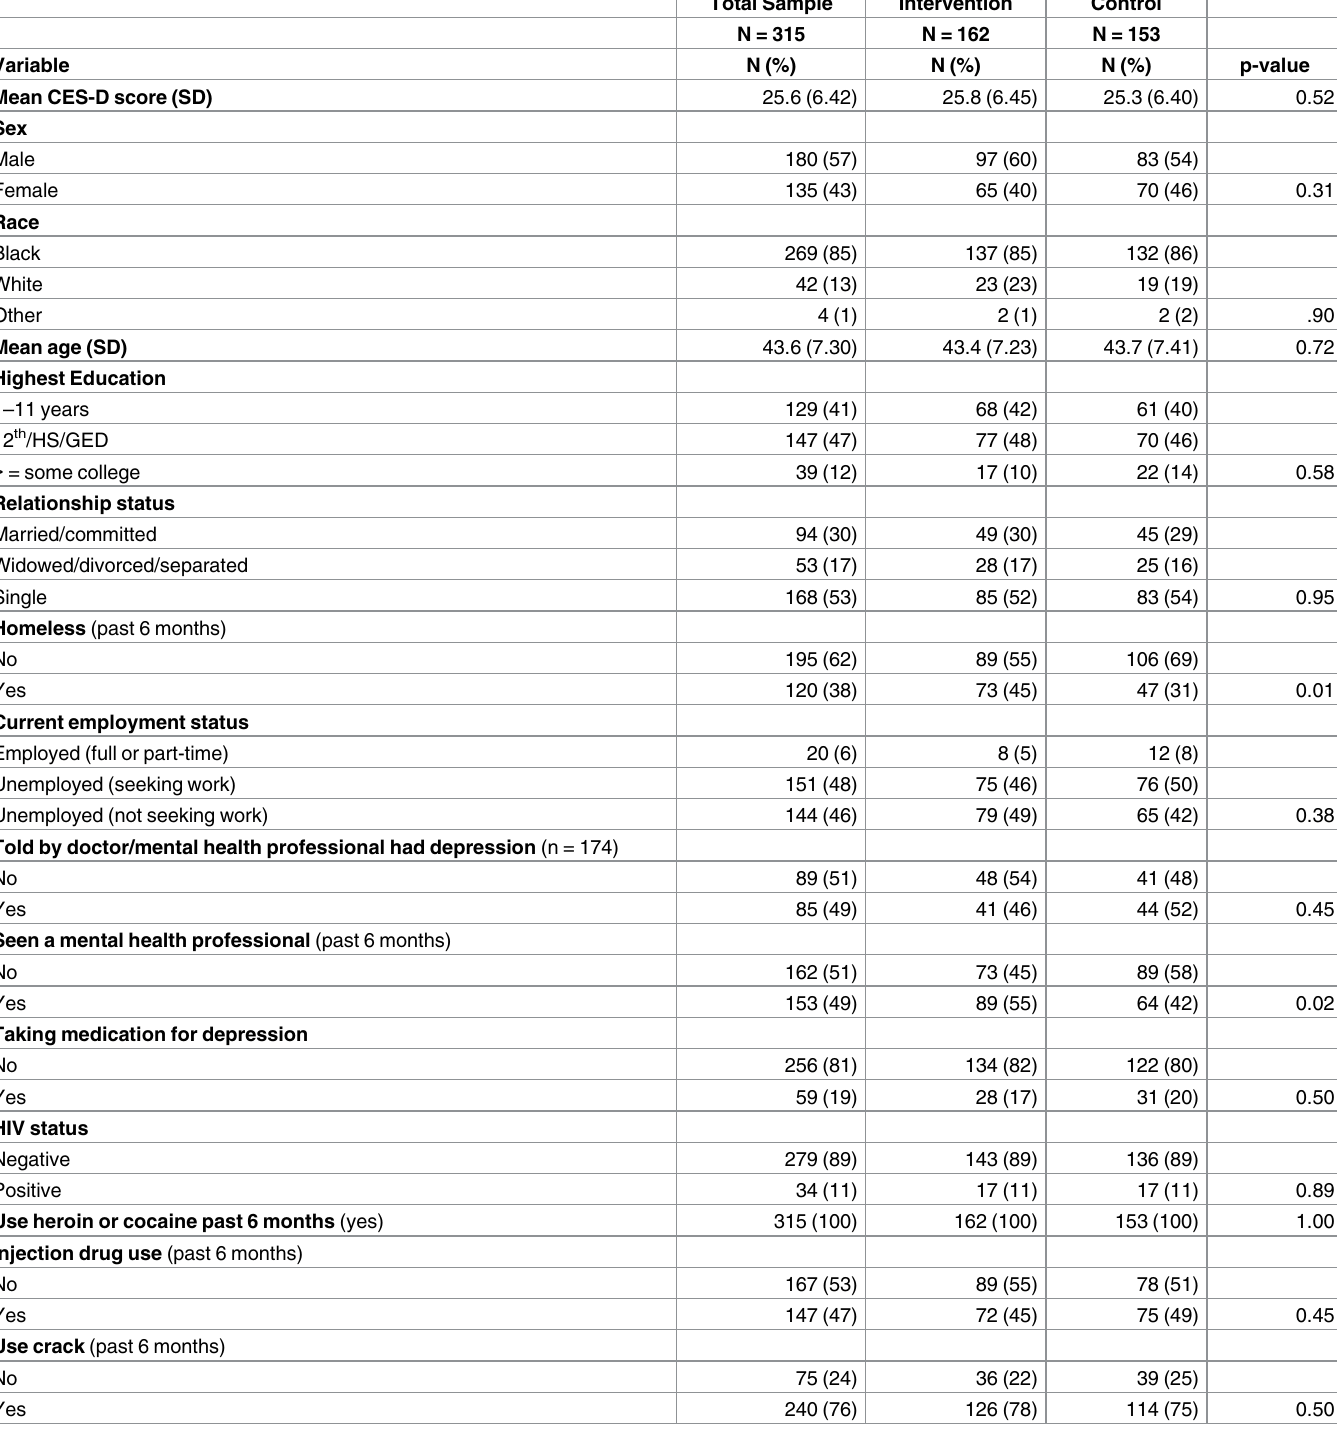
Table 1. Baseline characteristics of randomized participants (n = 315) in the Workshop study, Baltimore